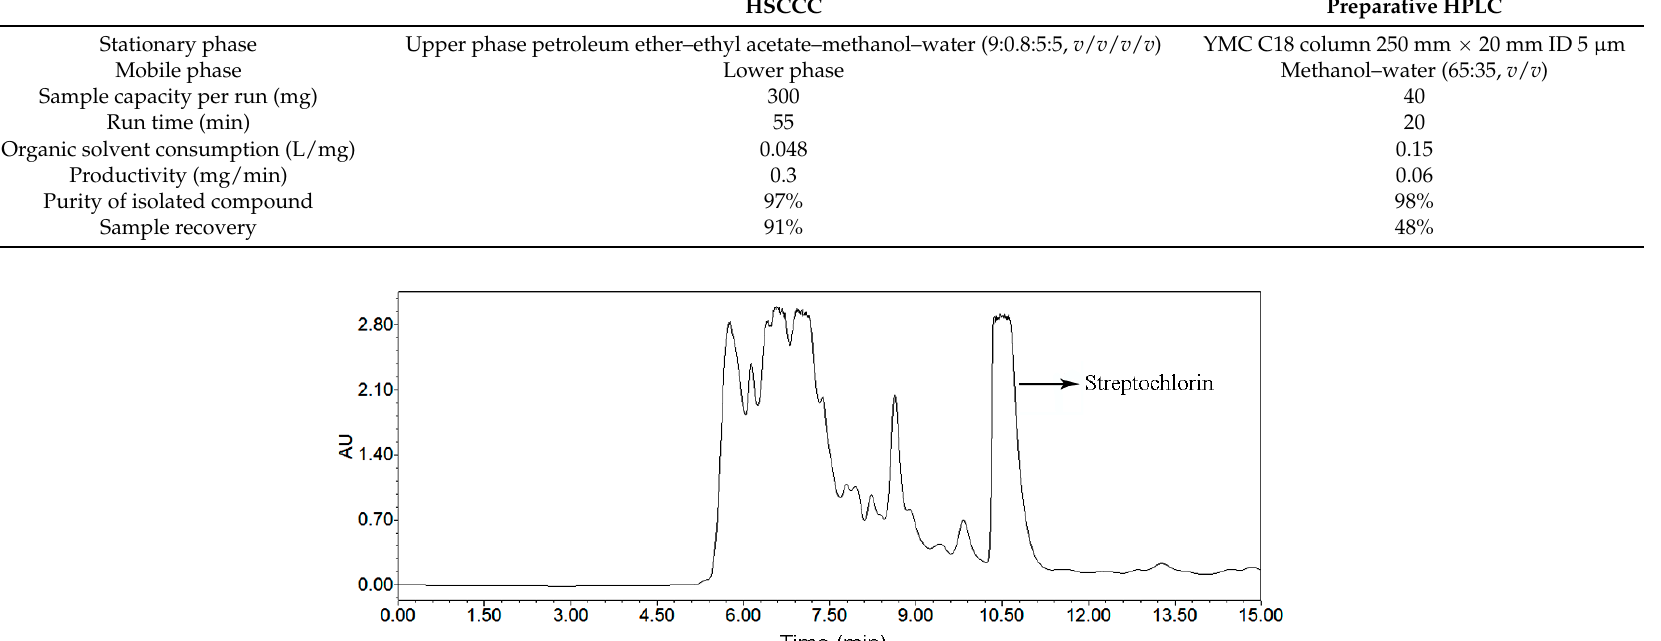
Figure 6. Preparative HPLC chromatogram of the crude extract of Streptomyces strain SYYLWHS-1-4, flow rate: 9.0 mL/min, methanol and water at the isocratic mode (65% methanol, 15 min), sample size: 500 µ L containing 40 mg crude extract, detection at 220